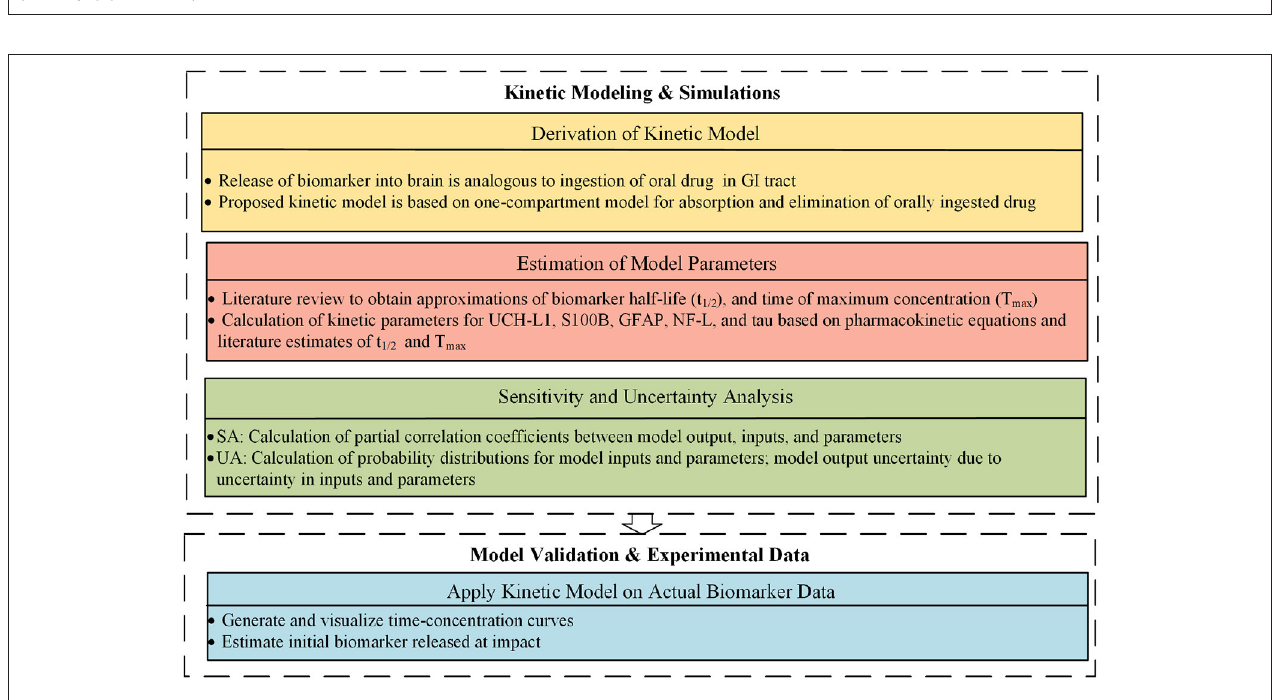
FIGURE 2 | Proposed